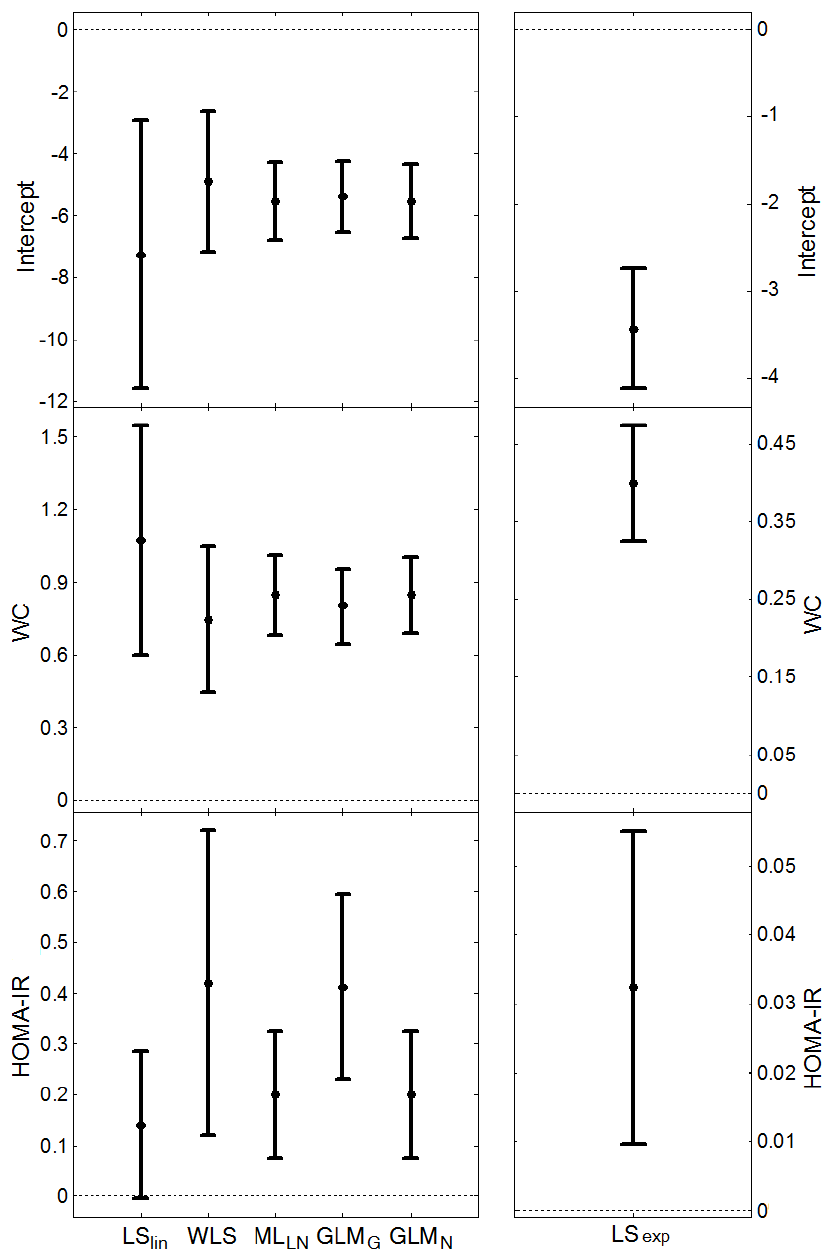
Figure 1. The parameter estimates and 95% confidence intervals for the different regression methods, when estimating CRP as a function of waist circumference (WC) and HOMA-IR, using n = 598